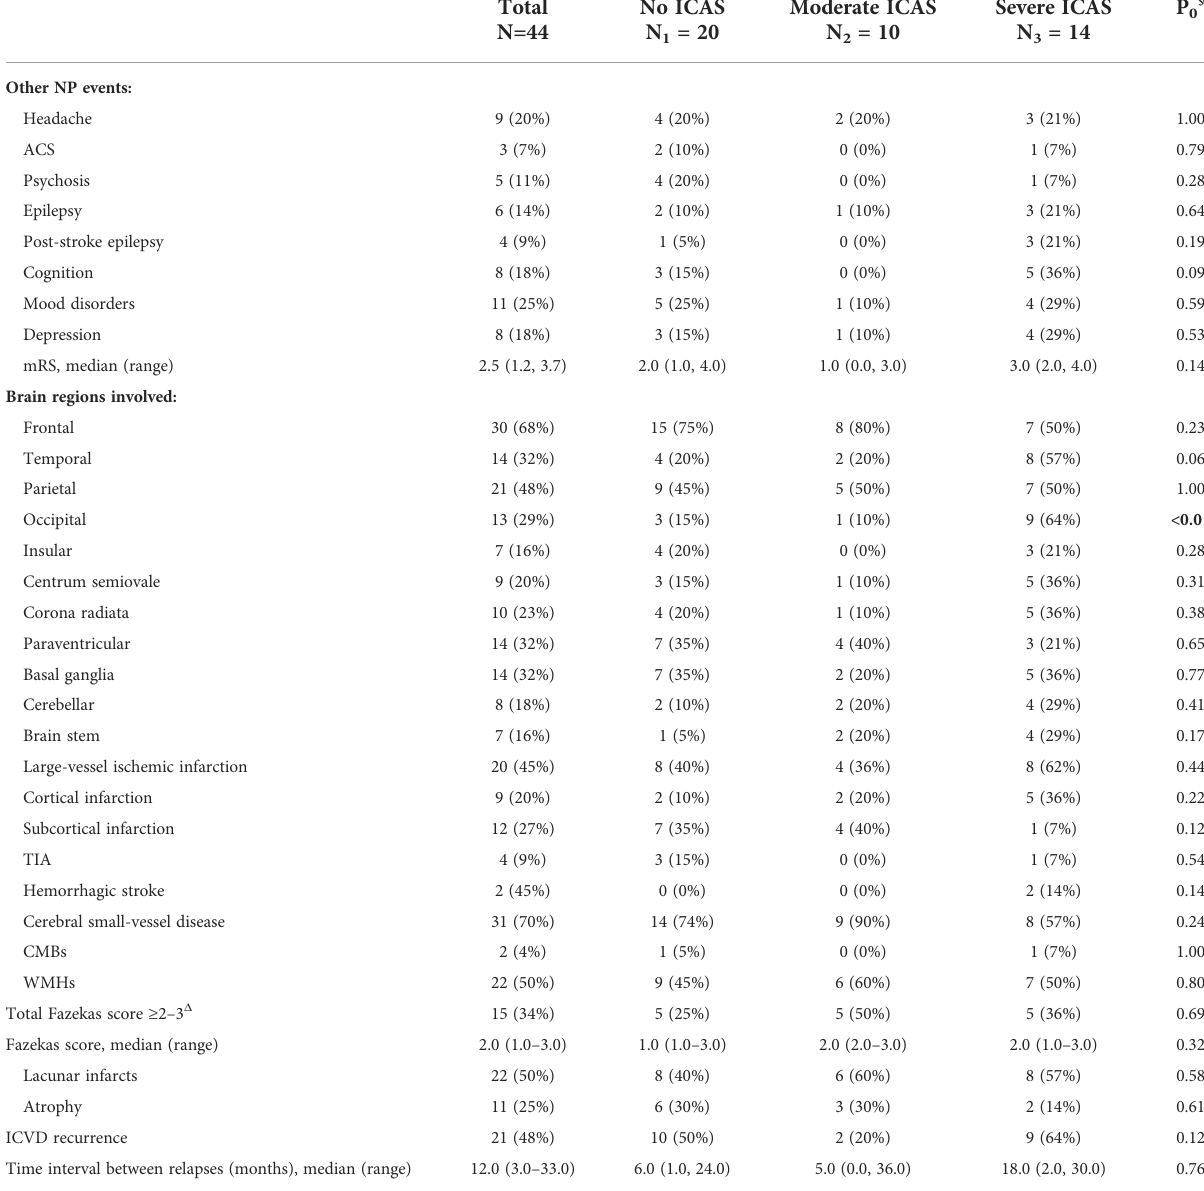
TABLE 2 The characteristics of neurological involvement in 44 lupus patients with ischemic cerebrovascular